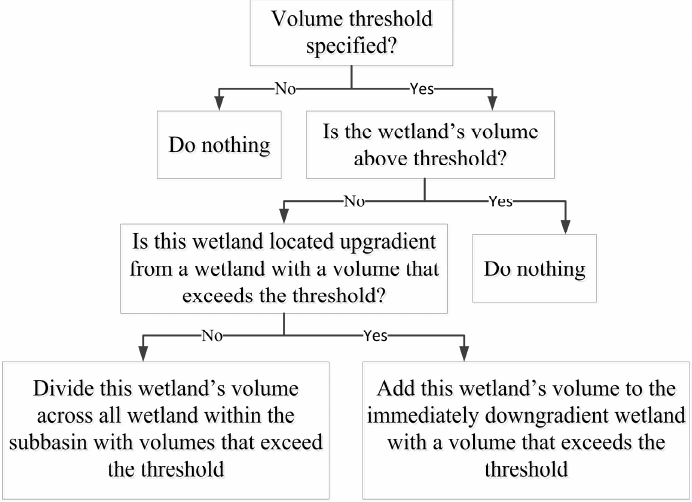
Figure 3. Decision tree of the modified SWAT wetland module based on the specified threshold concept.